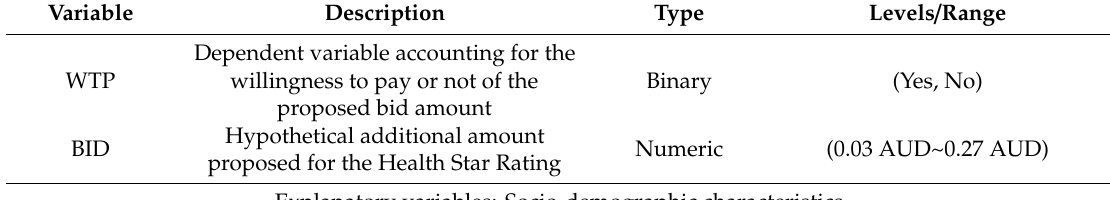
Table 1. Name, description and attributes of the study